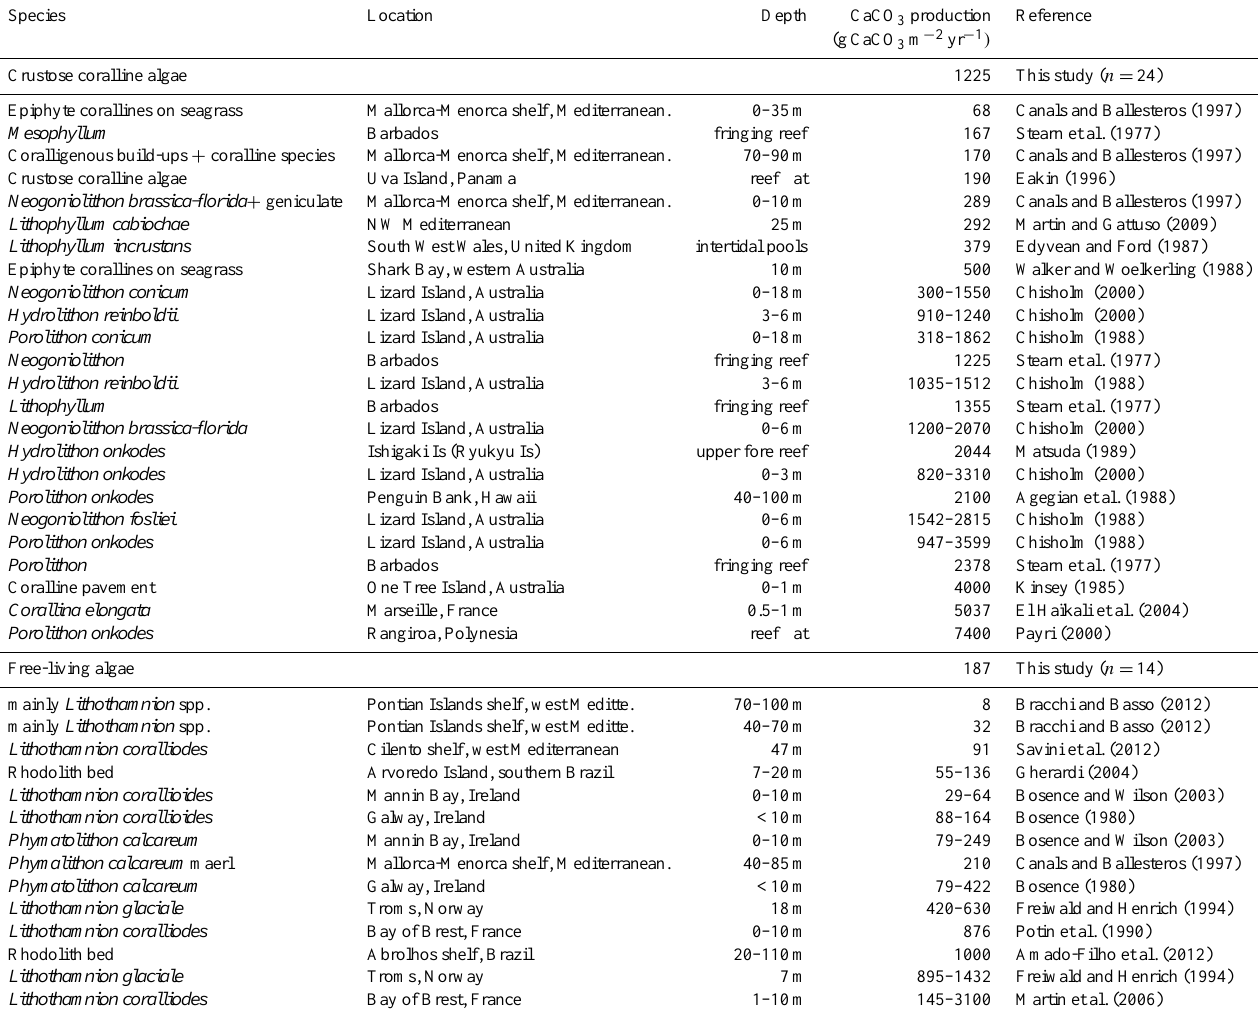
Table 4. Median net calcium carbonate production by coralline algae. Bracchi and Basso (2012) includes Lithophylloids, Canals and Balles- teros (1997) includes Peysonellia .